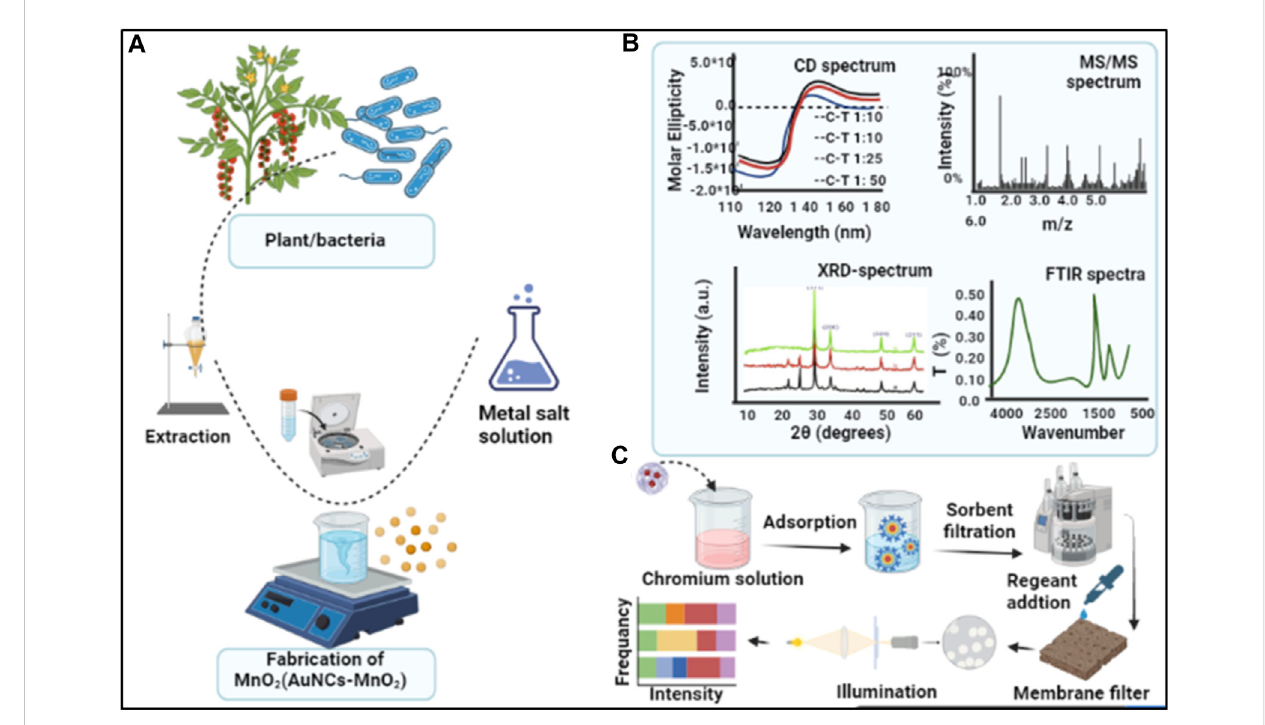
FIGURE 2 Steps for the colorimetric monitoring of analytes (A) Synthesis of MnO 2 (AuNCs-MnO 2 ) nanoparticle from plant/bacteria source, (B) fabricated nanoparticles are characterized with different techniques, (C) colorimetric detection of an analyte by adapting fl uorescence and colorimetric signal